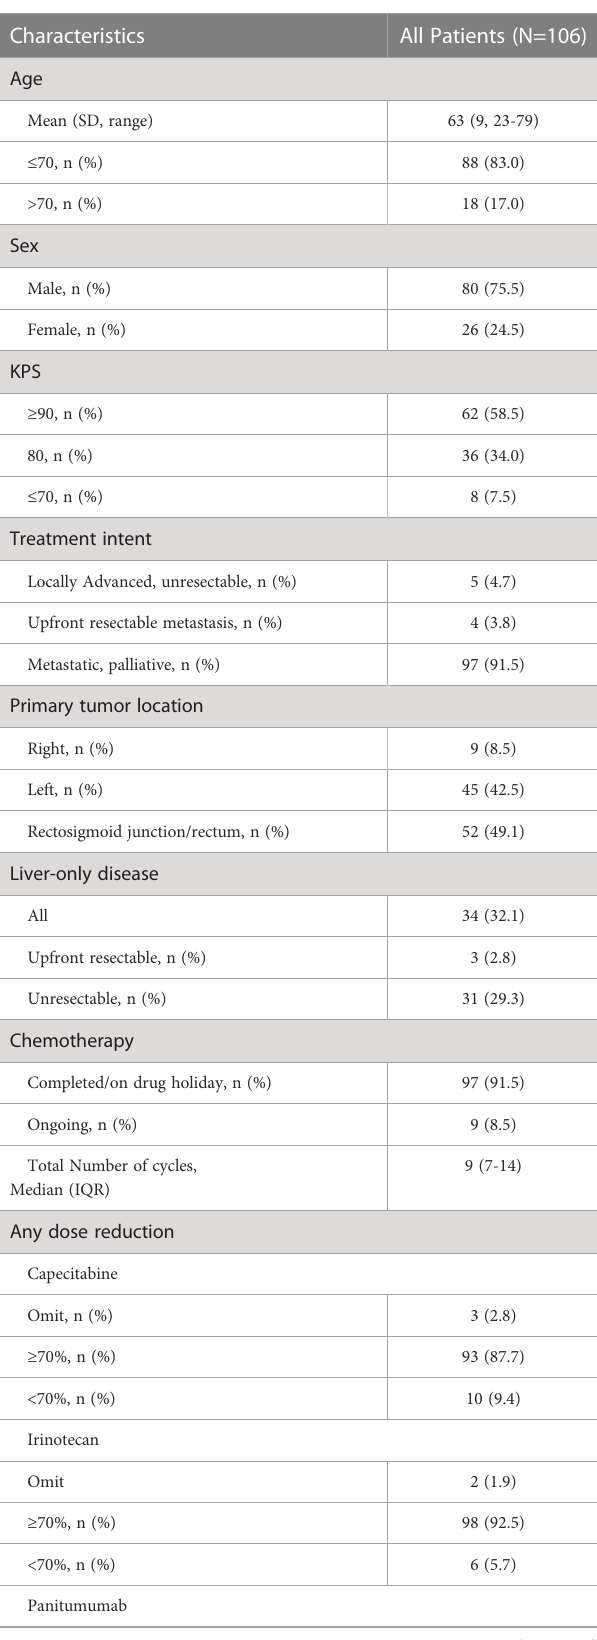
TABLE 1 Baseline characteristics of the study cohort, Hong Kong, 2019 – 2021 (N = 106).